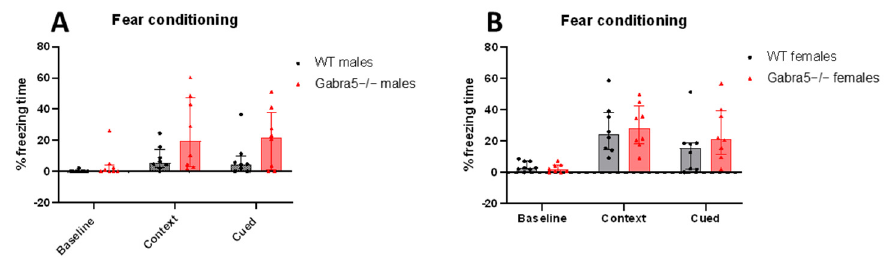
Figure 4. Contextual and delayed cued fear conditioning. ( A , B ) Baseline, contextual and cued- freezing time is depicted in percentage. No significant differences in the contextual and cued parameters between WT and Gabra5 − / − animals for both sexes. Fit linear Mixed Effect Model main genotype effect p > 0.05. All figures are depicted with median with interquartile range, n = 8.